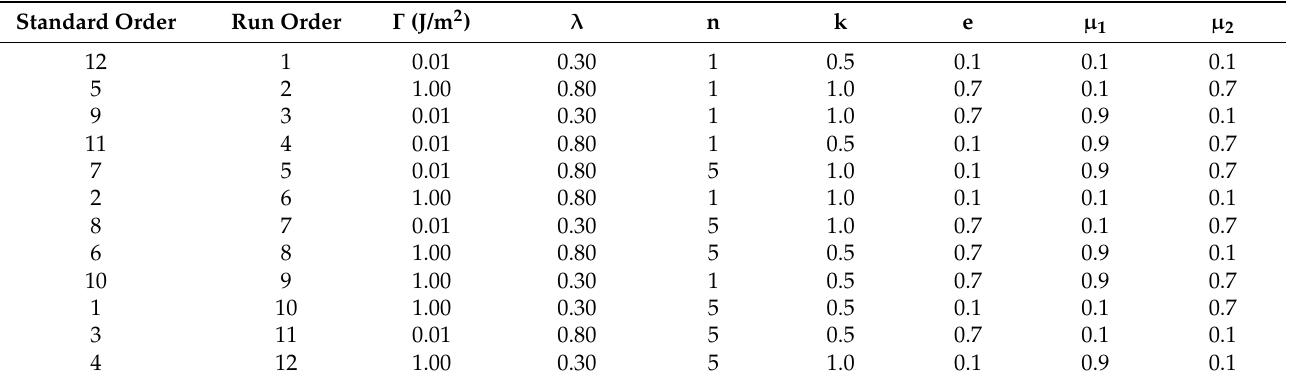
Table 2. Plackett–Burman design.